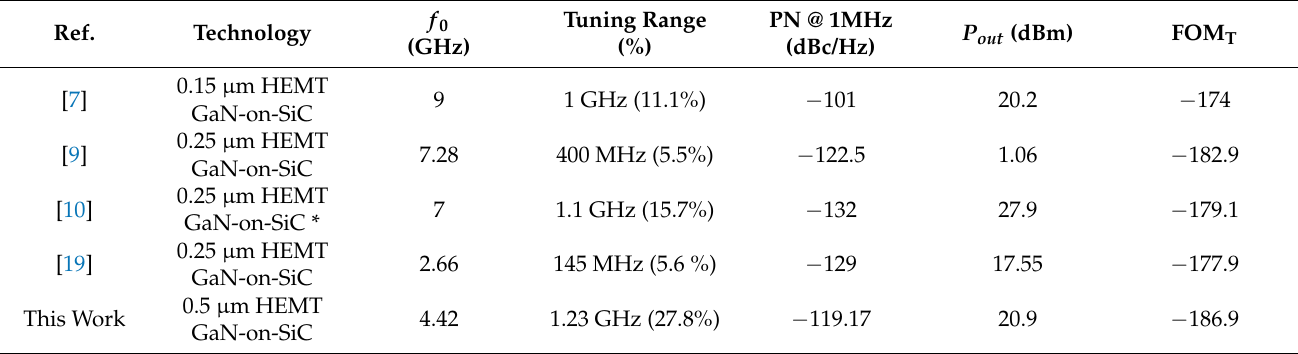
Figure 9. Measured output power versus ( a ) varactor biases and ( b ) selection modes for the switched inductor VCO. Table 2. Comparison of MMIC GaN HEMT VCO.